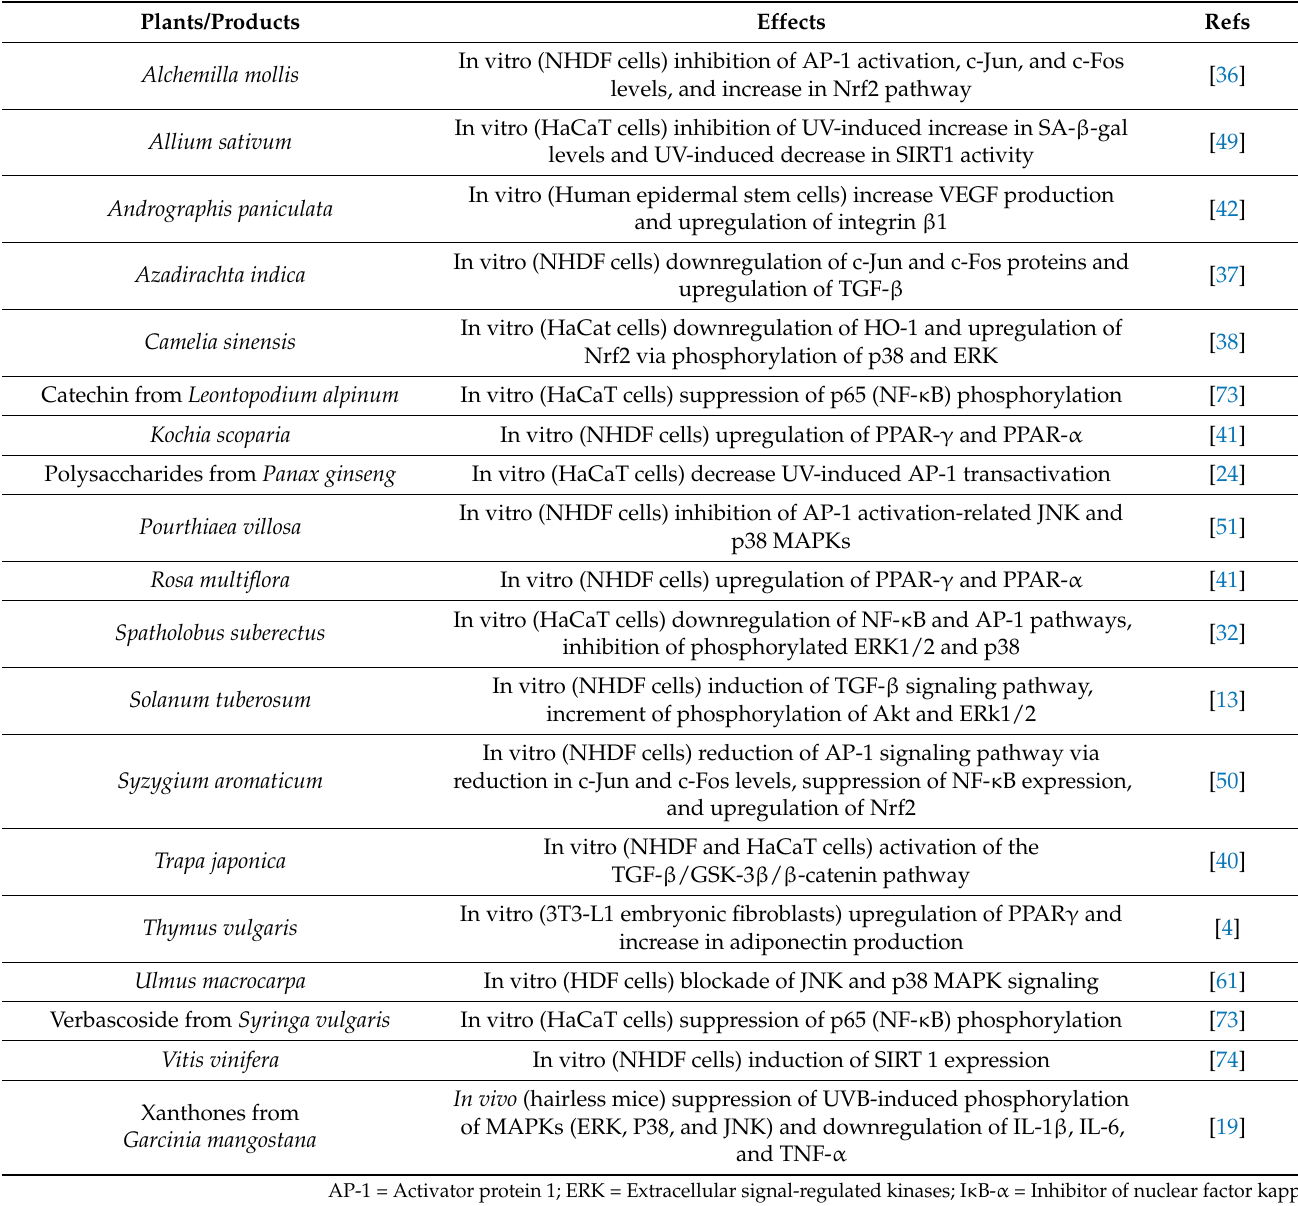
Table 4. Main isolated compounds and plant-herbal products with anti-aging effects acting on UV-induced signaling pathway